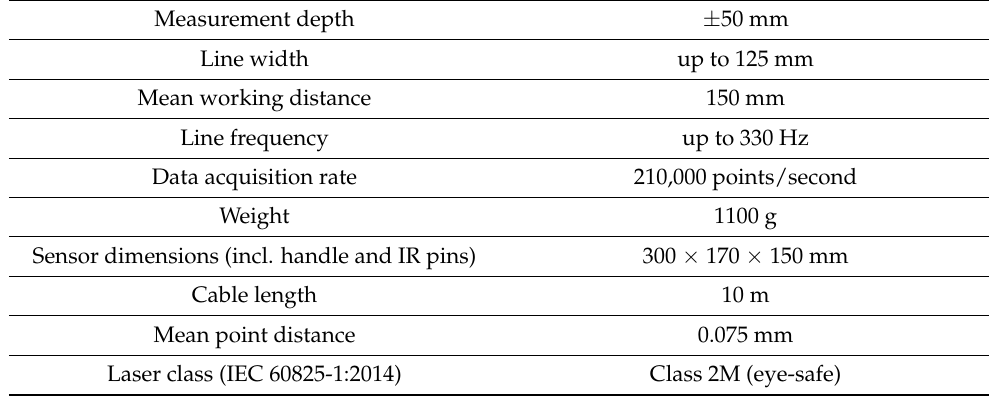
Table 3. Technical data of T-SCAN hand-held laser scanner in this paper.